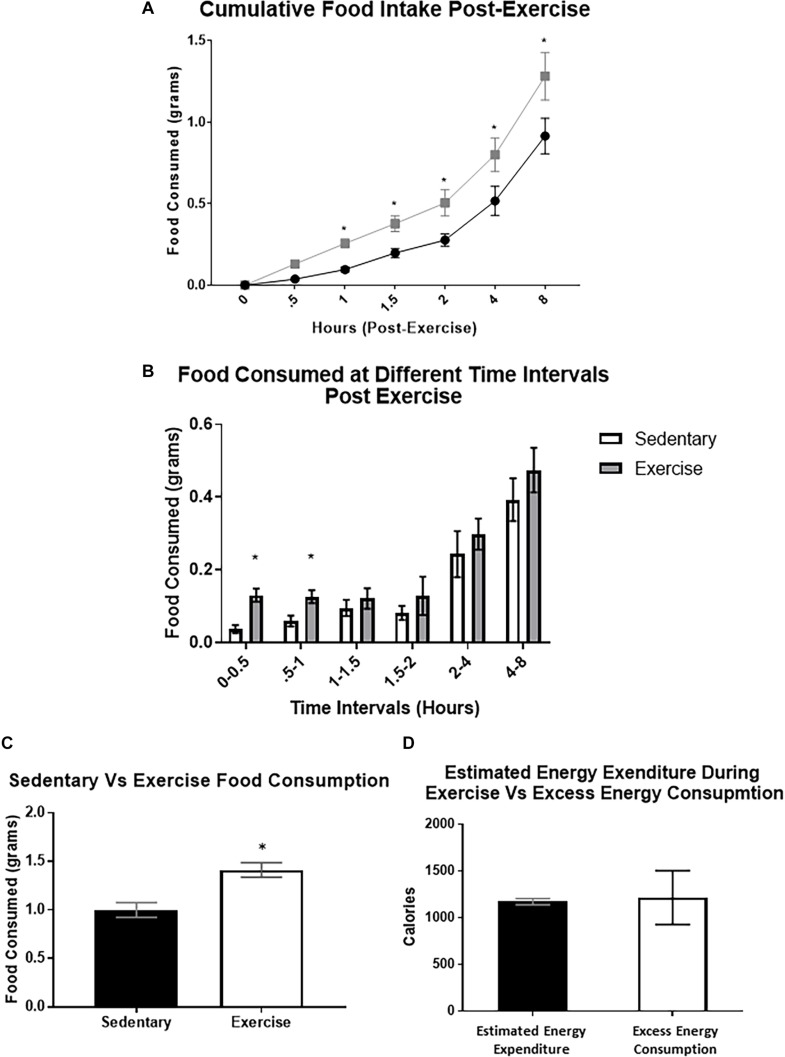
Food intake is increased immediately after a bout of moderate-intensity exercise. (A) Average cumulative food intake in mice over 8 h immediately after the sedentary or exercise conditions. (B) Average food consumed during specific time periods post-exercise (C) Total food consumed after 8-hour time period. (D) Estimated energy expenditure during the acute exercise bout compared to the excess caloric consumption (excess caloric consumption defined as calories consumed by the exercise group minus calories consumed by the sedentary group). Bar graphs show Mean + SEM. (N = 10 male mice per group), * indicates p < 0.05 vs. sedentary group.